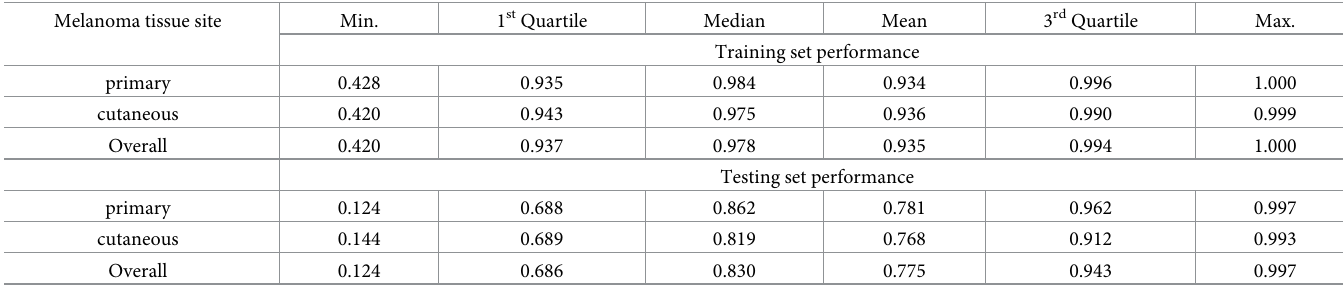
Table 1. Summary statistics of classification performances. Melanoma tissue